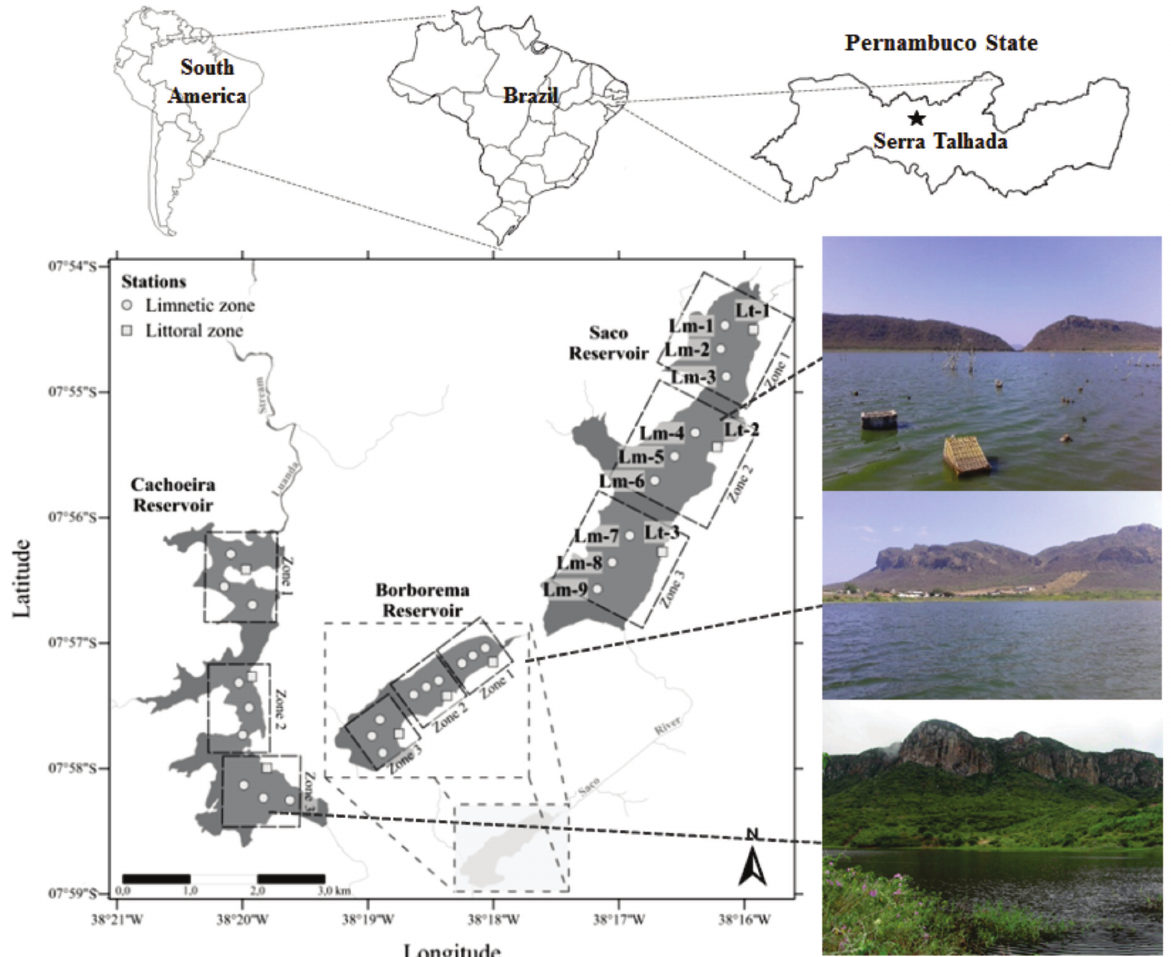
Figure 1 - Study area and sample design showing the distribution of the sampling points in the three reservoirs in a tropical semiarid basin (Pajeú